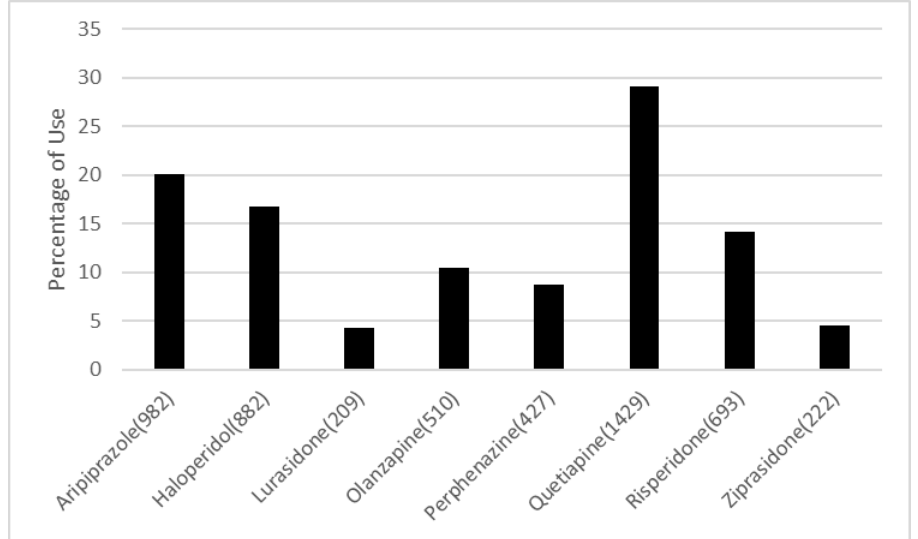
Figure 1. Percent of eligible PTSD patients receiving certain antipsychotics. As shown in the figure, no antipsychotics have the overall majority in treating eligible PTSD patients in our study (5294 eligible subjects from 4901 unique patients). Quetiapine, Aripiprazole and Haloperidol are the top three most used antipsychotics in PTSD patients. Table 1. Baseline